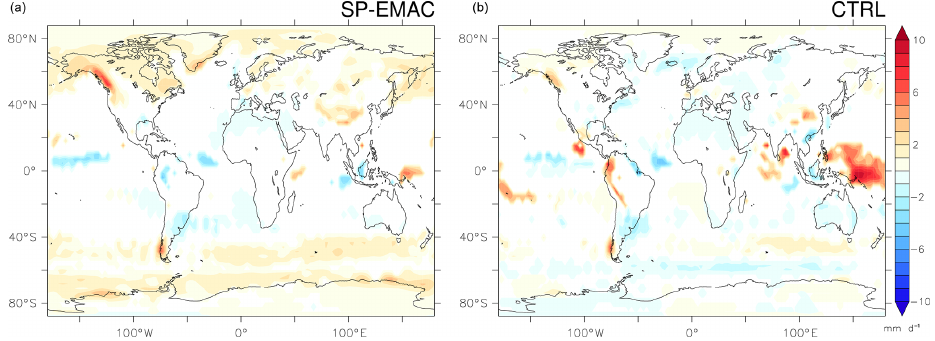
Figure 4. Differences in precipitation of the SP-EMAC ensemble (a) and CTRL (b) in contrast to global observations (GPCP). Coloured areas show only regions with significant differences in precipitation (analysed with t tests on a significance level of